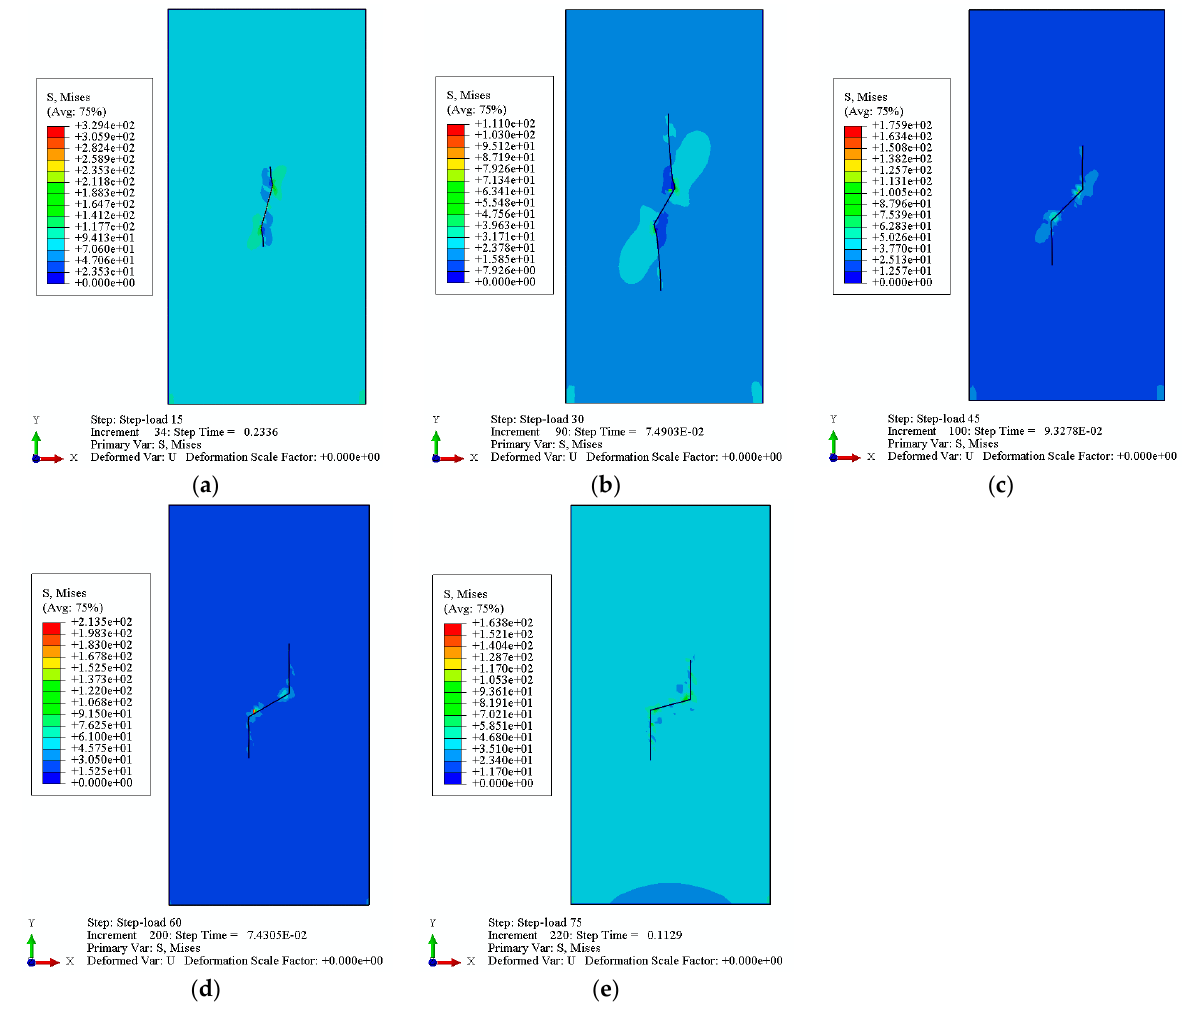
Figure 7. Fracture propagation numerical simulation of single joint-fissured concrete sample where the single crack thickness is 0.5 mm. ( a ) β = 15°; ( b ) β = 30°; ( c ) β = 45°; ( d ) β = 60°; ( e ) β = 75°.